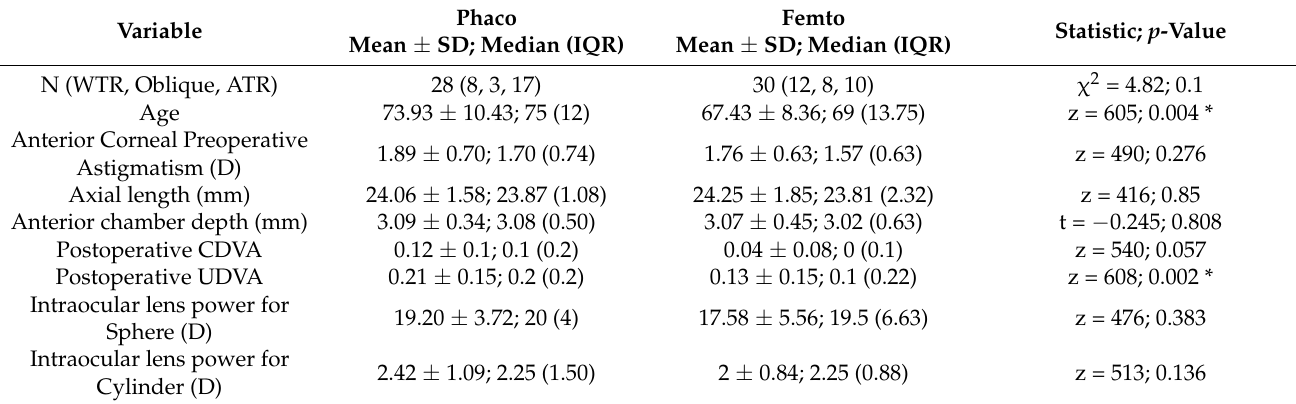
Table 1. Descriptive analysis for demographic